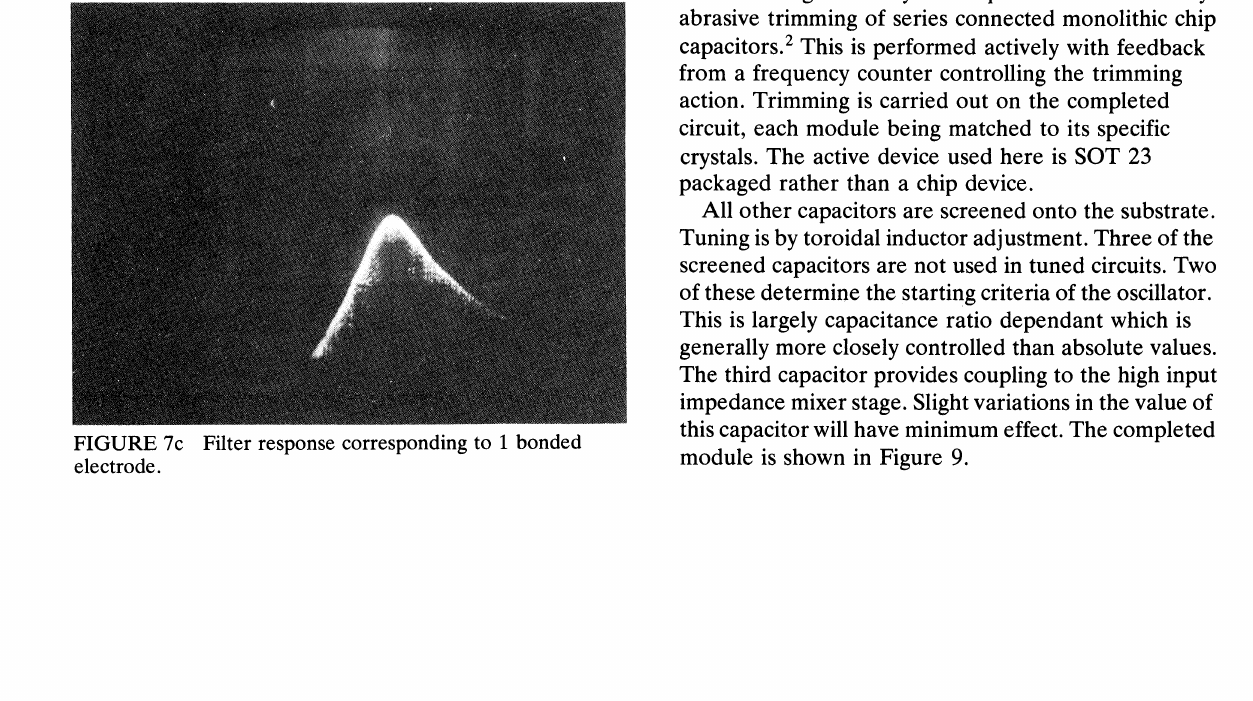
FIGURE 7b Filter response corresponding to 5 bonded electrodes.